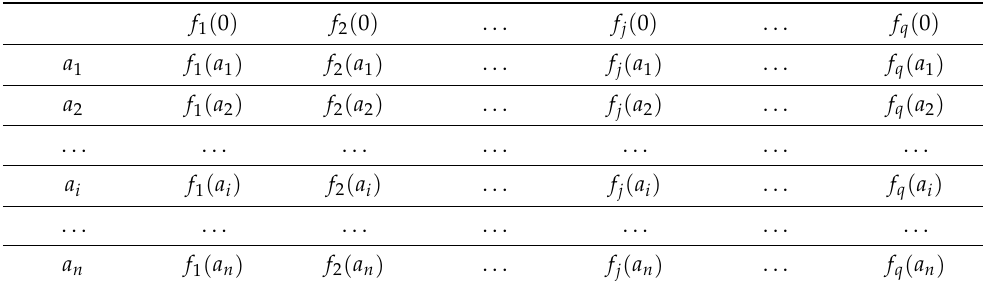
Table A1. Preference